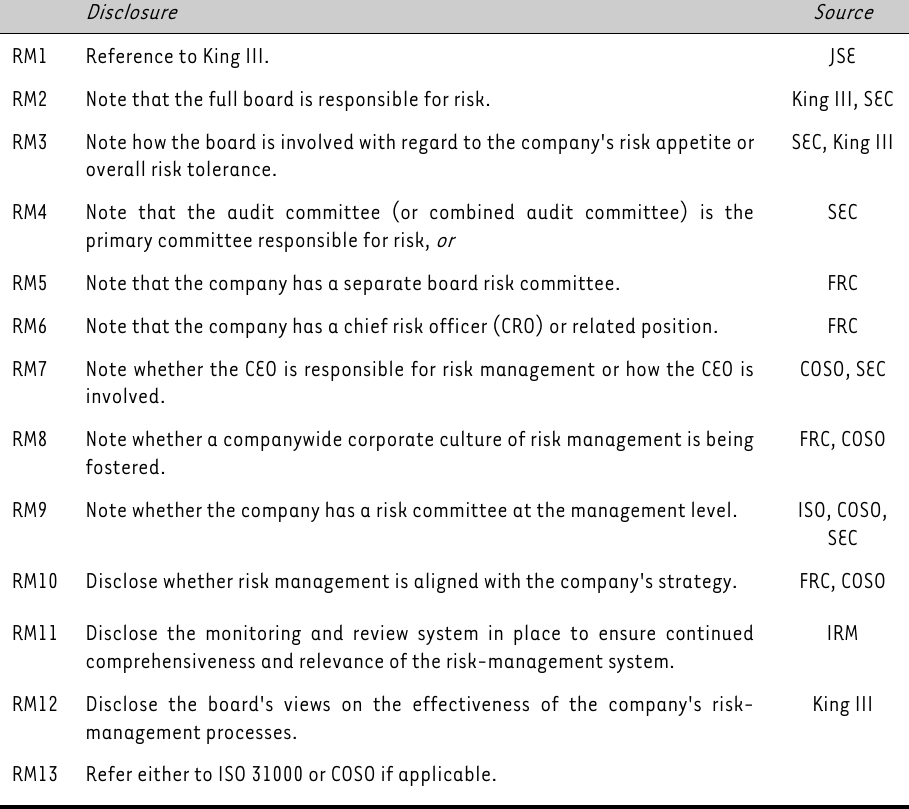
Risk-disclosure index for risk